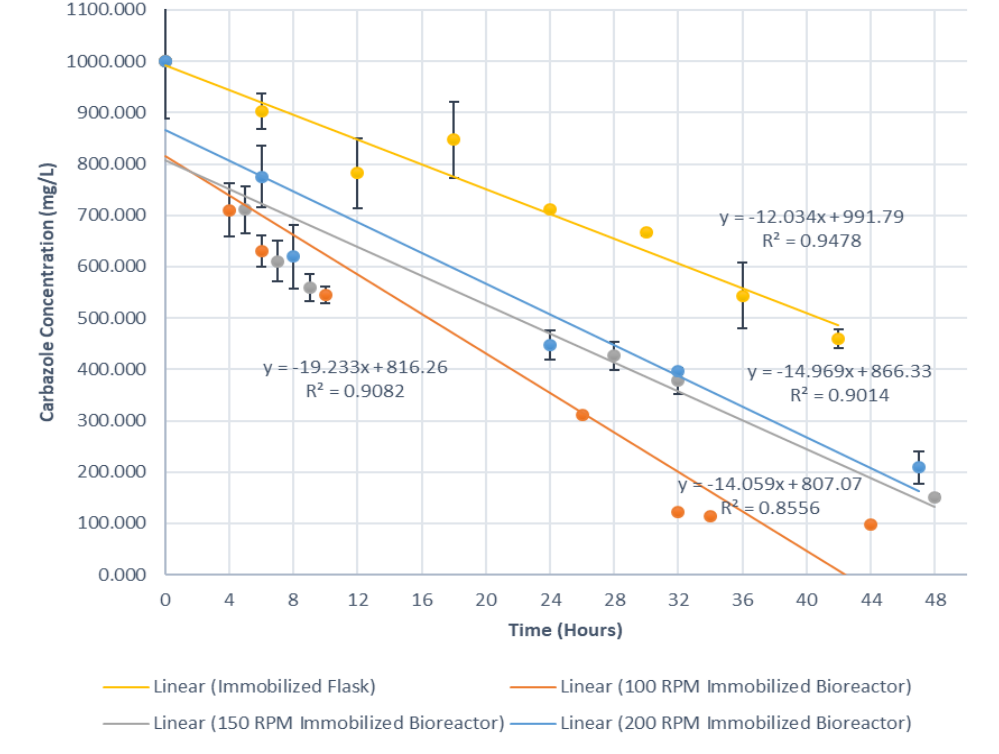
Figure 4. Performance comparison between bioreactor scale and flask Table 4. Performance enhanced comparison from shake flask to bioreactor scale with various agitation